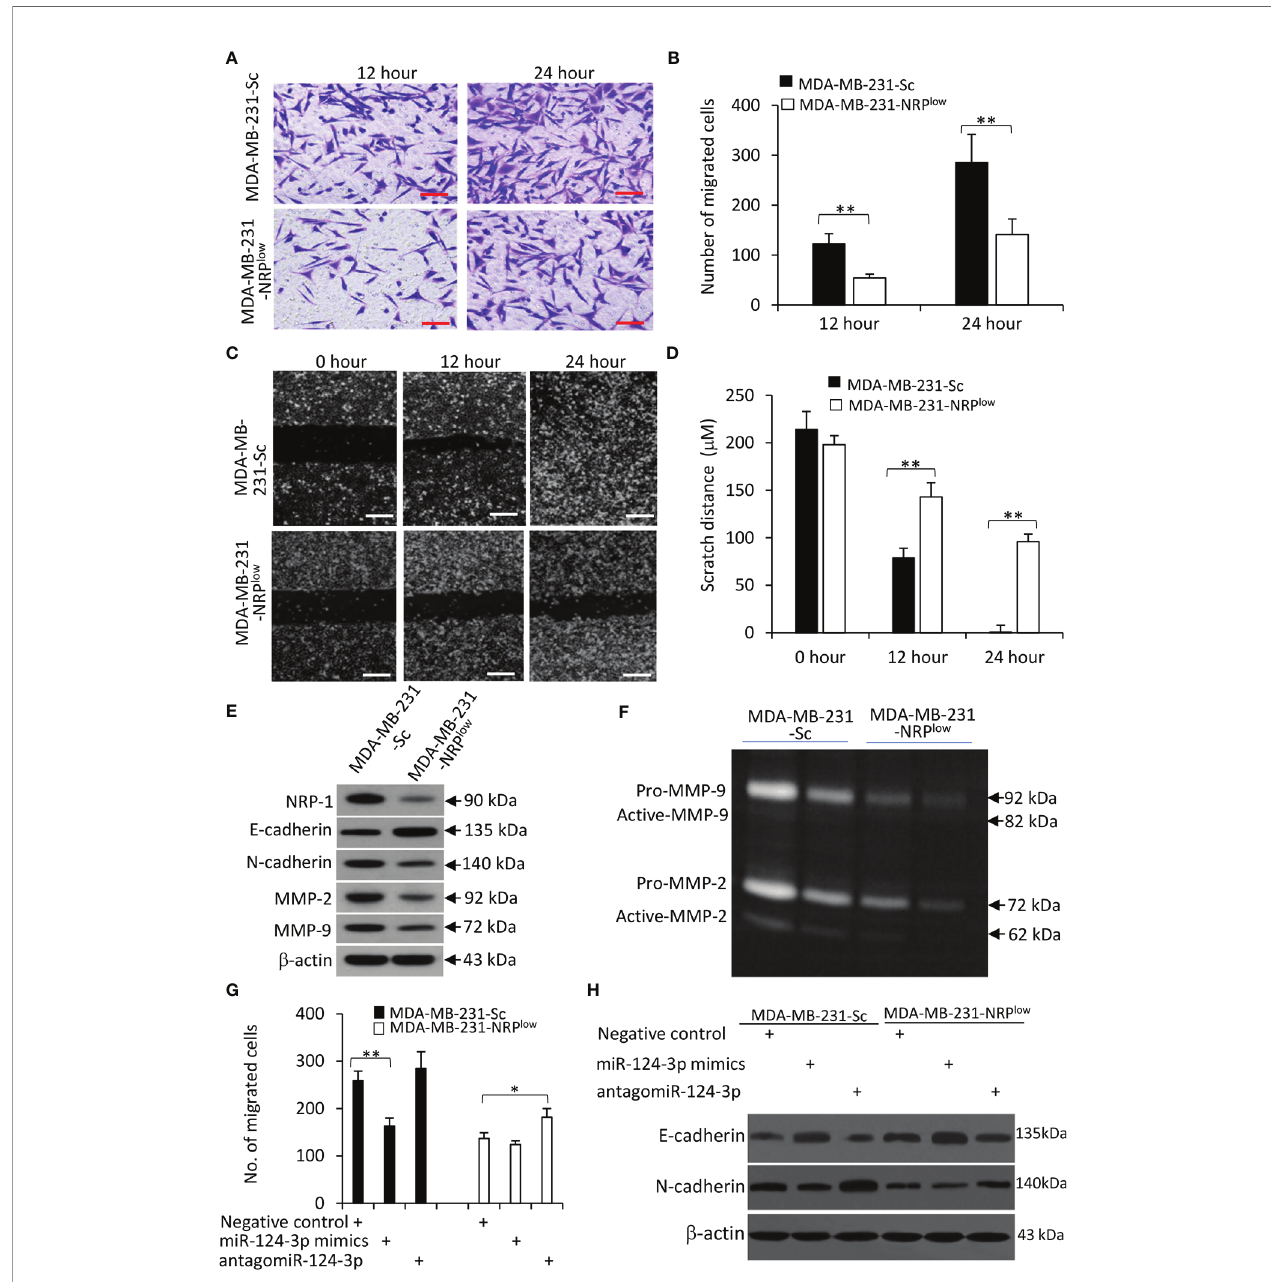
FIGURE 6 | The miR-124-3p/NRP-1 axis regulates cell migration and EMT. (A, B) Transwell migration assays were used to evaluate the migrating ability of MDA-MB- 231-Sc and MDA-MB-231-NRP low . (A) Migrated cells were stained with crystalline violet at 12 and 24 h. Magni fi cation bar = 100 µm. (B) The numbers of migrated cells were counted. (C, D) The above cells were subjected to scratch migration assays. Scratch areas were imaged (C) and scratch distances were measured (D) at 0, 12 and 24 h. Magni fi cation bar = 200 µm. (E) The above cells were subjected to Western blot analysis. (F) Conditioned media from MDA-MB-231-Sc and MDA-MB-231- NRP low (2× 10 4 or 1 × 10 4 ) cells, which had been incubated for 48 h. Gelatin zymography assay was used to detect the activity of MMP-9 and MMP-2. (G, H) Cells were transfected with negative control, miR-124-3p mimics or antagomiR-124-3p oligonucleotides for 24 and then subjected to Transwell assays as in (A) . (G) Migrated cells were counted 24 h later. (H) Cells were subjected to Western blot analysis. “ *P < 0.05 ” and “ ** P < 0.001 ” [t-test in (B, D) ; one-way ANOVA with a Tukey post-hoc test in (H) ] indicate a signi fi cant difference. “ **P < 0.001 ” indicates a signi fi cant difference from MDA-MB-231-Sc spontaneously metastasize from the primary tumors to distant injected into the mice had formed signi fi cantly fewer sites including livers (28). Primary 4T1-NRP low tumors metastatic nodules (Number: 45.6± 8.5) in livers (with an average number of 45.6± 8.5) than 4T1-Sc cells (Number: were signi fi cantly smaller than control 4T1-Sc tumors 102.7 ±18.6) ( Figures 7E, F ). ( Figure S6 in Supplementary Material ). 4T1-NRP low cells